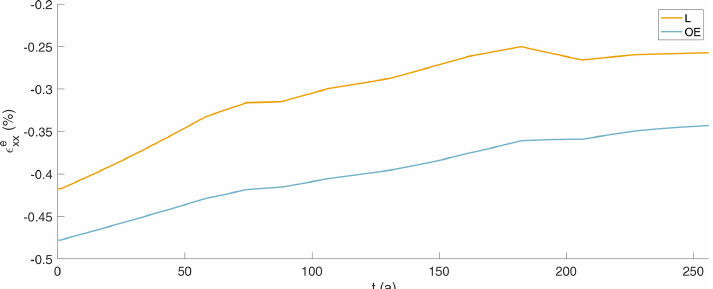
Figure B11. The evolution of the simulated elastic part of Hencky strain at the ice base inside and outside the east of the channel in percent over the simulation time of 256 years. The initial elastic response of the grounded ice becoming afloat has vanished as the grounding line to far upstream. Avoiding model shocks with a spin-up of 75 years leads to a continuous Hencky strain at t = 0